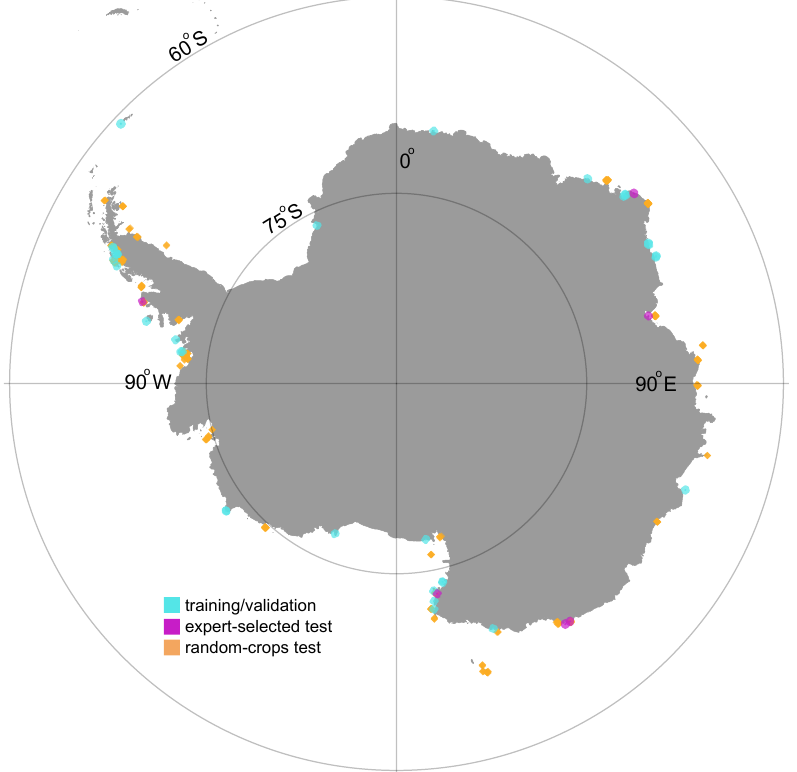
Figure 2. Training/validation set (light-blue), expert-selected test set (magenta), and random-crop test set (orange). Polygons denote entire Worldview-3 panchromatic scenes for the training/validation set and the expert-selected test set, and 1 km 2 crops within panchromatic Worldview-3 scenes for the random-crop test